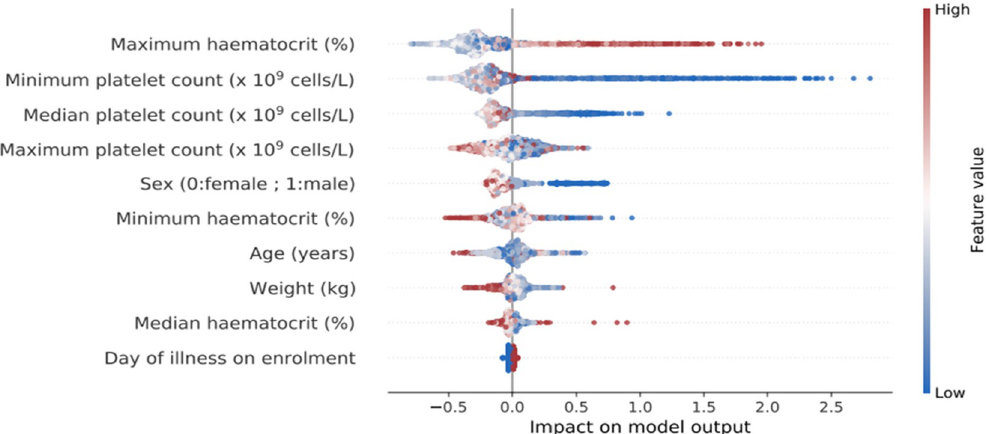
Fig 2. Summary plot of SHAP values for the XGBoost model. The plot shows the contribution of individual predictors and their range of values towards final model output prediction, where shock and no shock are represented by 1 and 0 on the x- axis respectively. The main predictors are arranged in descending importance for the model. The colours of the individual features represent whether the values are high or low. For example, a higher maximum haematocrit (red) is associated with a positive impact on model output and thus associated with dengue shock. Female sex is represented by blue (0) and male sex represented by red